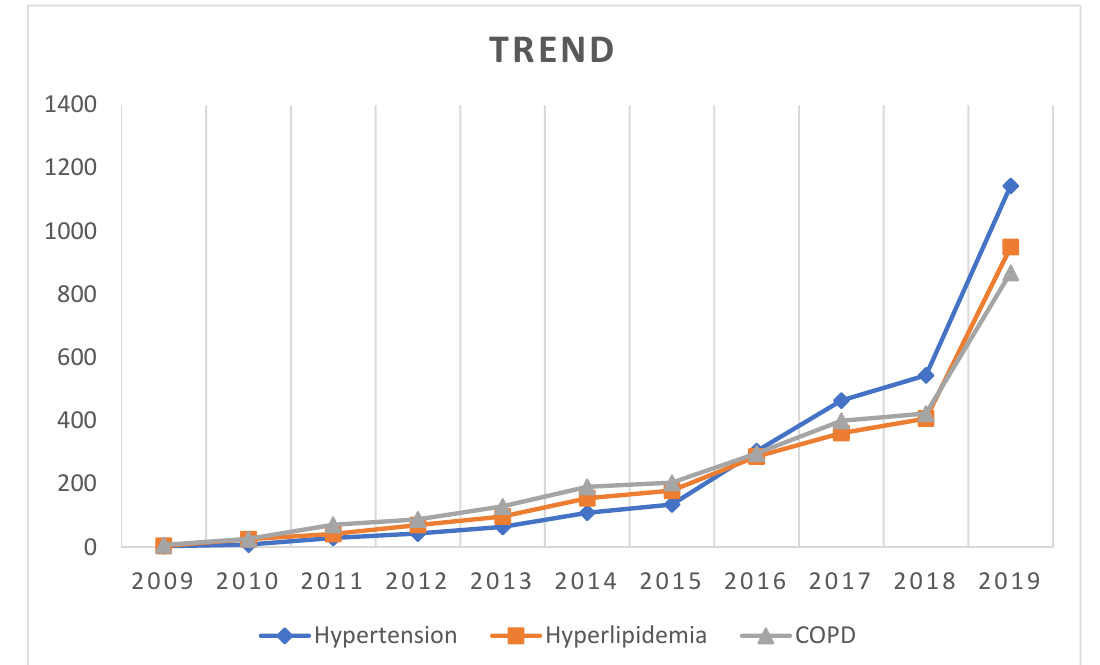
Figure 2. Trend in the number of patients with hypertension, hyperlipidemia, and COPD admitted to the PC wards during 2009–2019. COPD, chronic obstructive pulmonary disease.